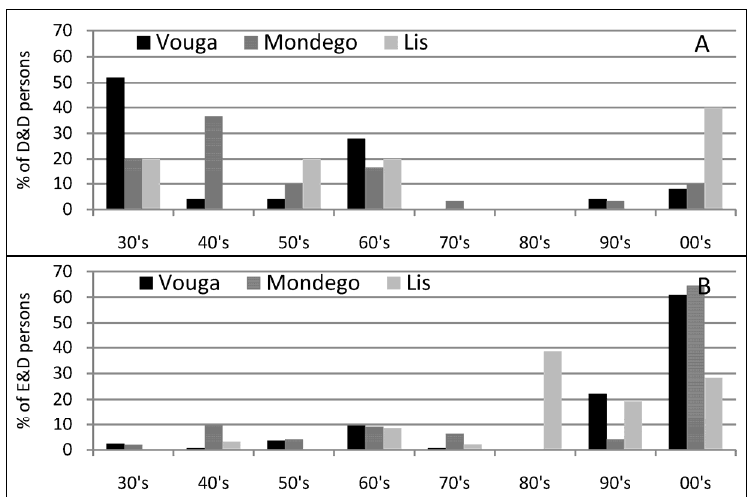
Figure 4. Relative frequency by decade of dead and disappeared (D & D) persons ( A ) and evacuated and displaced (E & D) persons ( B ).